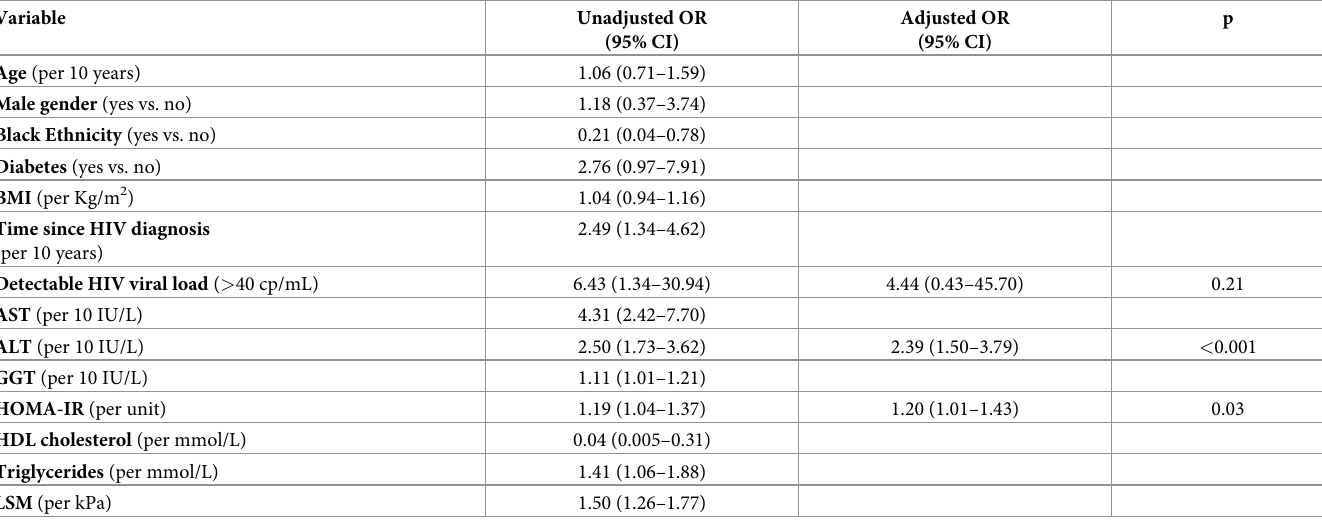
Table 3. Clinical and metabolic variables associated with NASH by univariate and multivariate